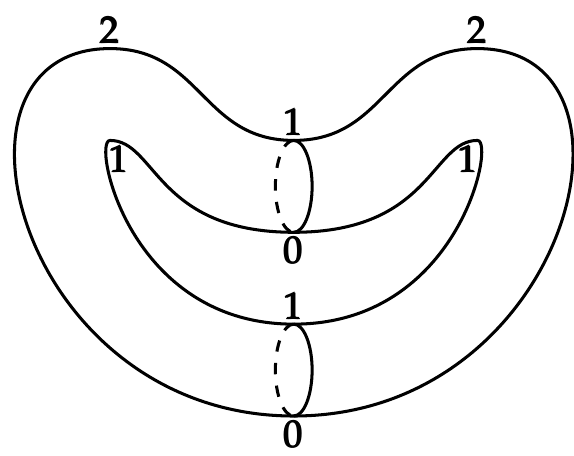
Figure 11. Deforming the torus does not changes the Morse index.